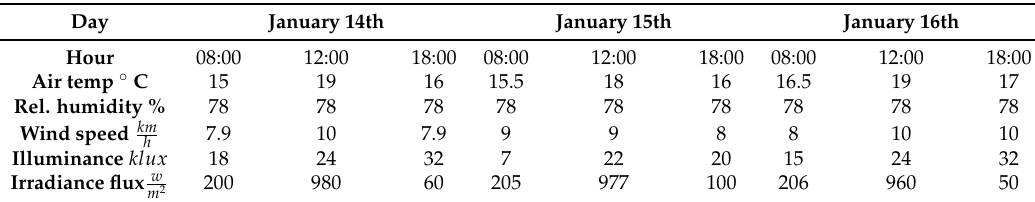
Figure 5. Proposed architecture to carry out the analysis of the hot-spot detection. Table 3. The environmental conditions for the field thermographic measurements.